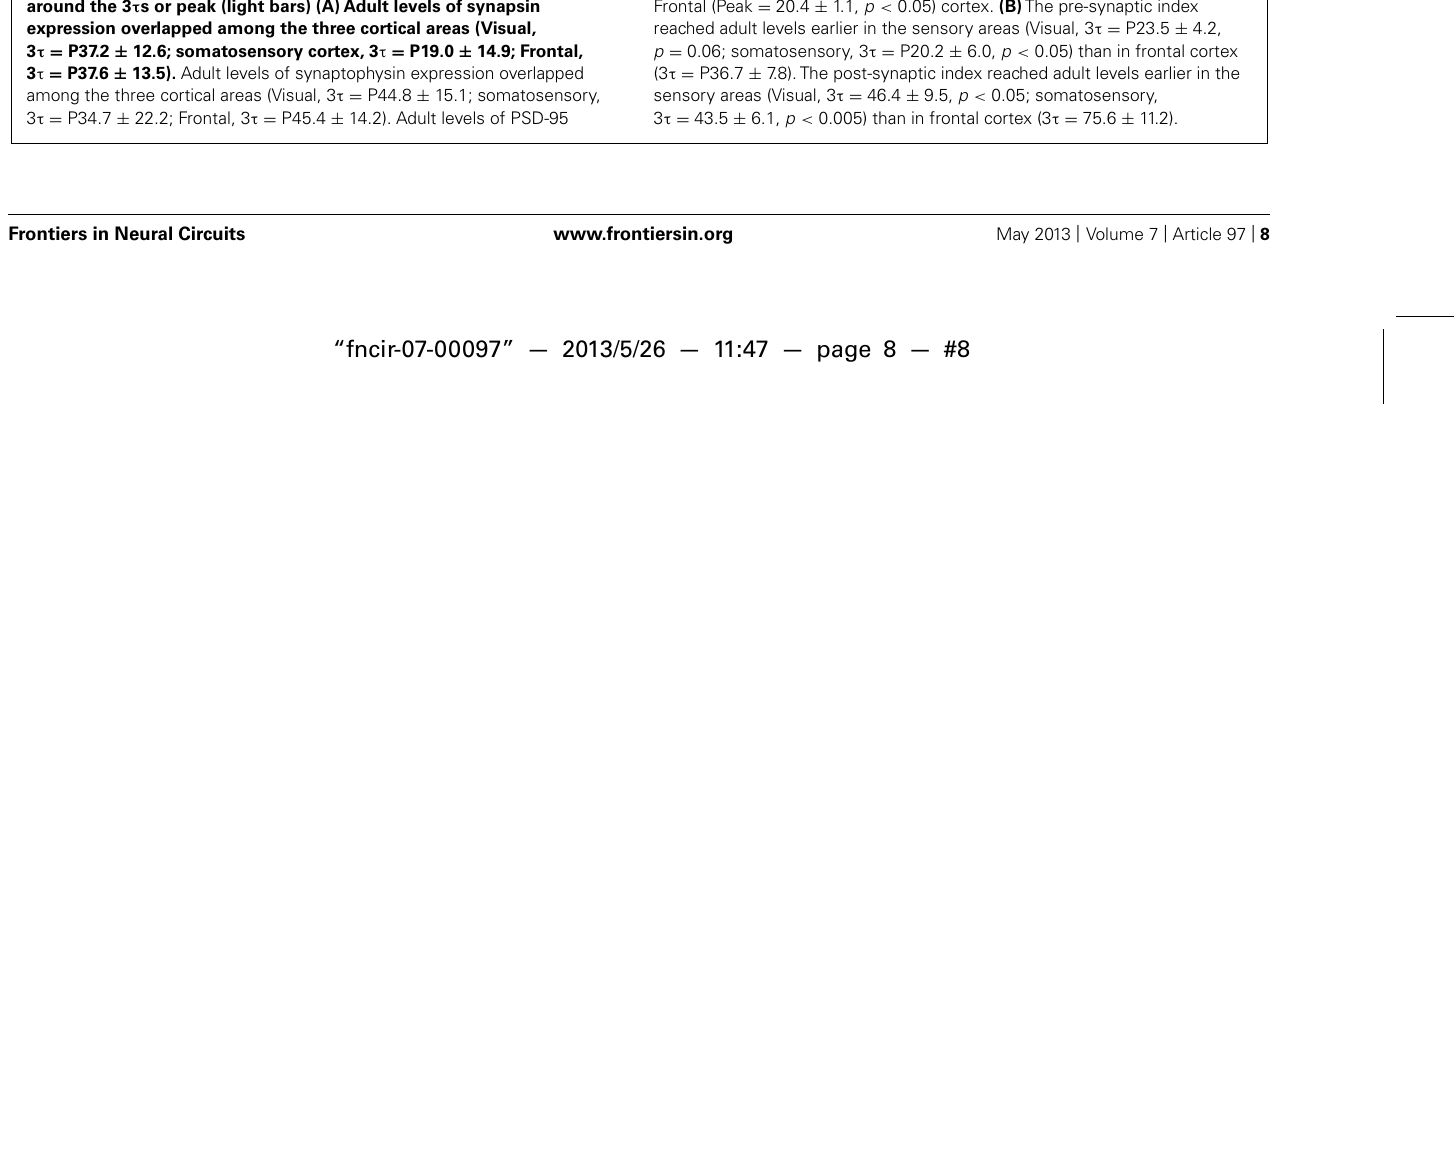
expression overlapped among the three cortical areas (Visual, 3 τ = 61.9 ± 12.3; somatosensory, 3 τ = 61.2 ± 21.4; Frontal, 3 τ = 49.1 ± 11.8). Peak in gephyrin expression was significantly later inVisual (Peak = 29.3 ± 5.1), than somatosensory (Peak = 12.8 ± 5.1, p < 0.05) and Frontal (Peak = 20.4 ± 1.1, p < 0.05) cortex. (B) The pre-synaptic index reached adult levels earlier in the sensory areas (Visual, 3 τ = P23.5 ± 4.2, p = 0.06; somatosensory, 3 τ = P20.2 ± 6.0, p < 0.05) than in frontal cortex (3 τ = P36.7 ± 7.8).The post-synaptic index reached adult levels earlier in the sensory areas (Visual, 3 τ = 46.4 ± 9.5, p < 0.05; somatosensory, 3 τ = 43.5 ± 6.1, p < 0.005) than in frontal cortex (3 τ = 75.6 ±